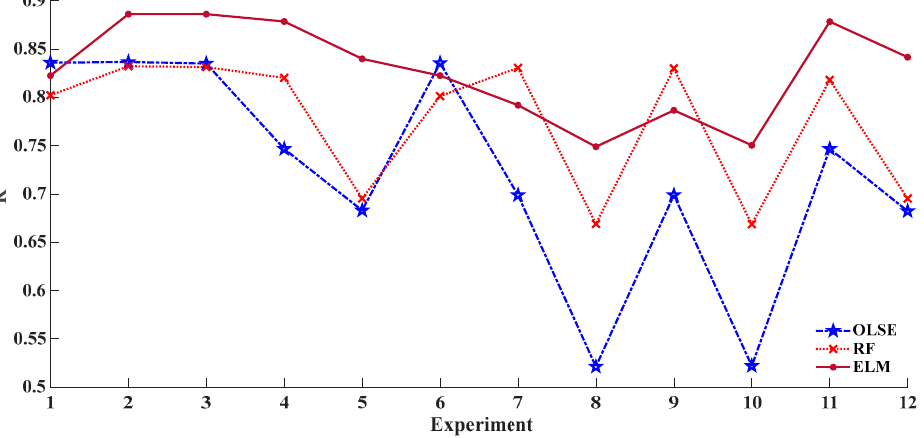
Figure 4. Stability of different predicted models with different preprocessing approaches.